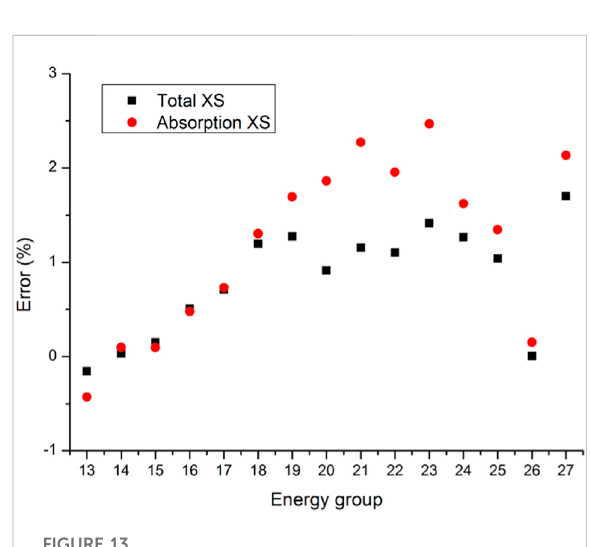
FIGURE 13 Comparison of 238 U total and absorption cross sections in Region